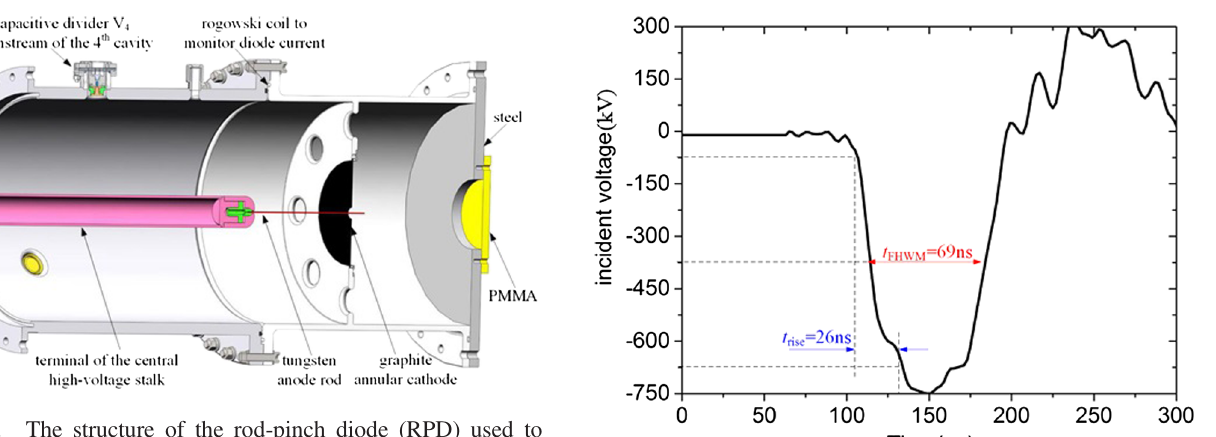
FIG. 2. The structure of the rod-pinch diode (RPD) used to produce high-brightness x rays.